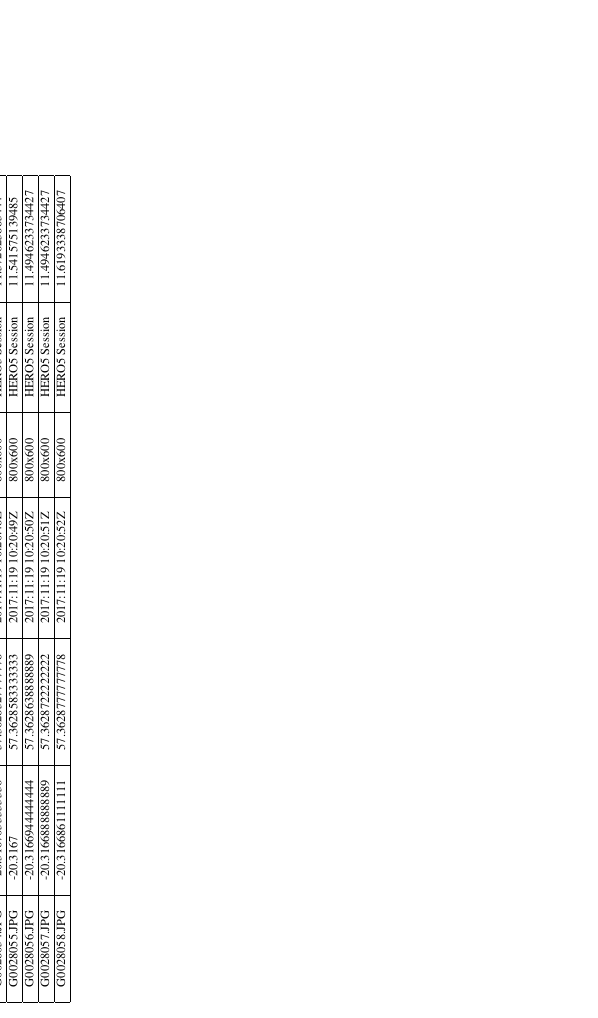
Table 2. Examples of Exif metadata extracted from headers of JPG